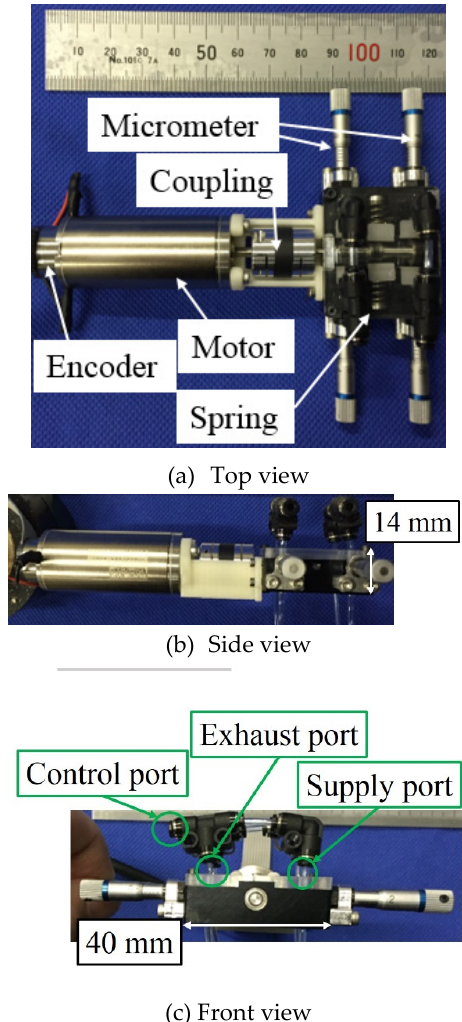
Figure 3 . Pinch-type servo valve developed in this study. Figure 3. Pinch-type servo valve developed in this